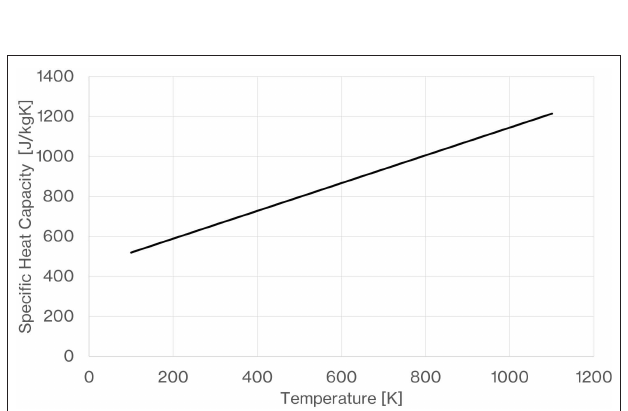
FIGURE 23 | Sensitivity to heat exchanger effectiveness.